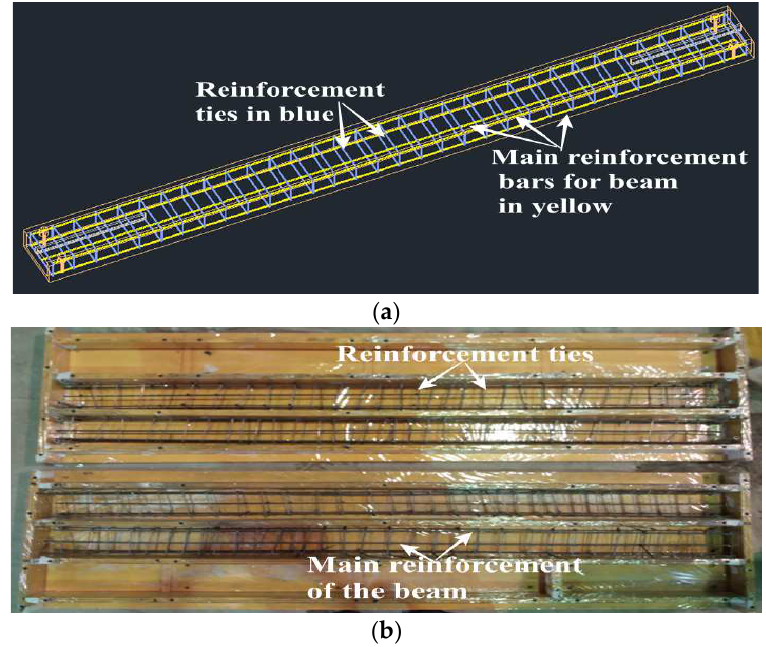
Figure 7. Details of beam reinforcement: ( a ) AutoCAD drawing; ( b ) laboratory experiment.